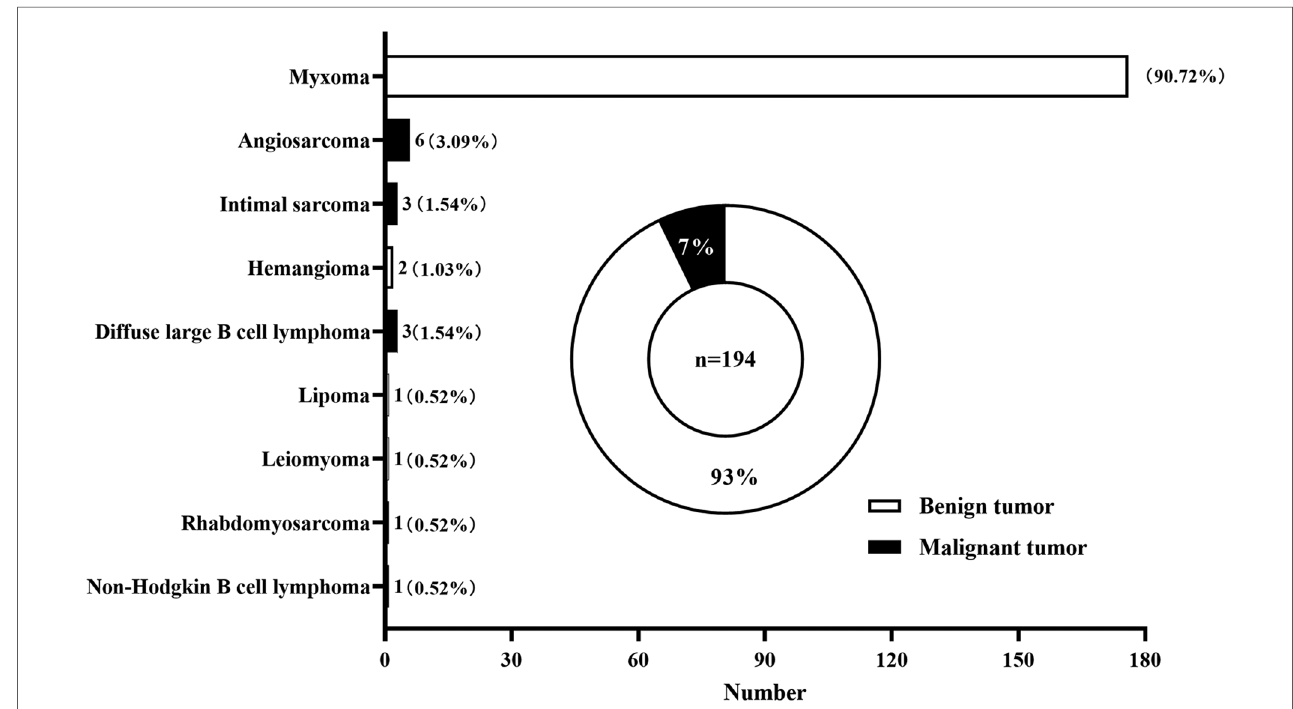
FIGURE 1 distribution of primary cardiac tumors located in the atrium diagnosed and treated at division of cardiothoracic and vascular surgery of tongji hospital between 2012 and